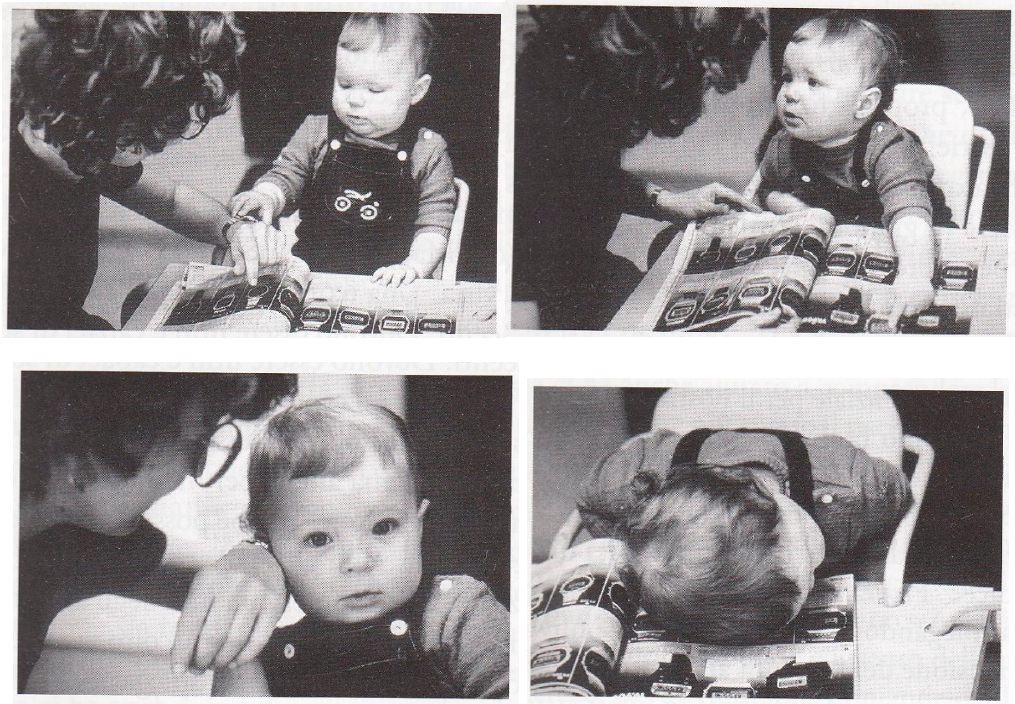
Figure 2. Laura and the clock: mini-story taken from the personal diary of a little girl (“Arcobaleno” Infant-Toddler Centre, 1981, Reggio Emilia) [17] (p.